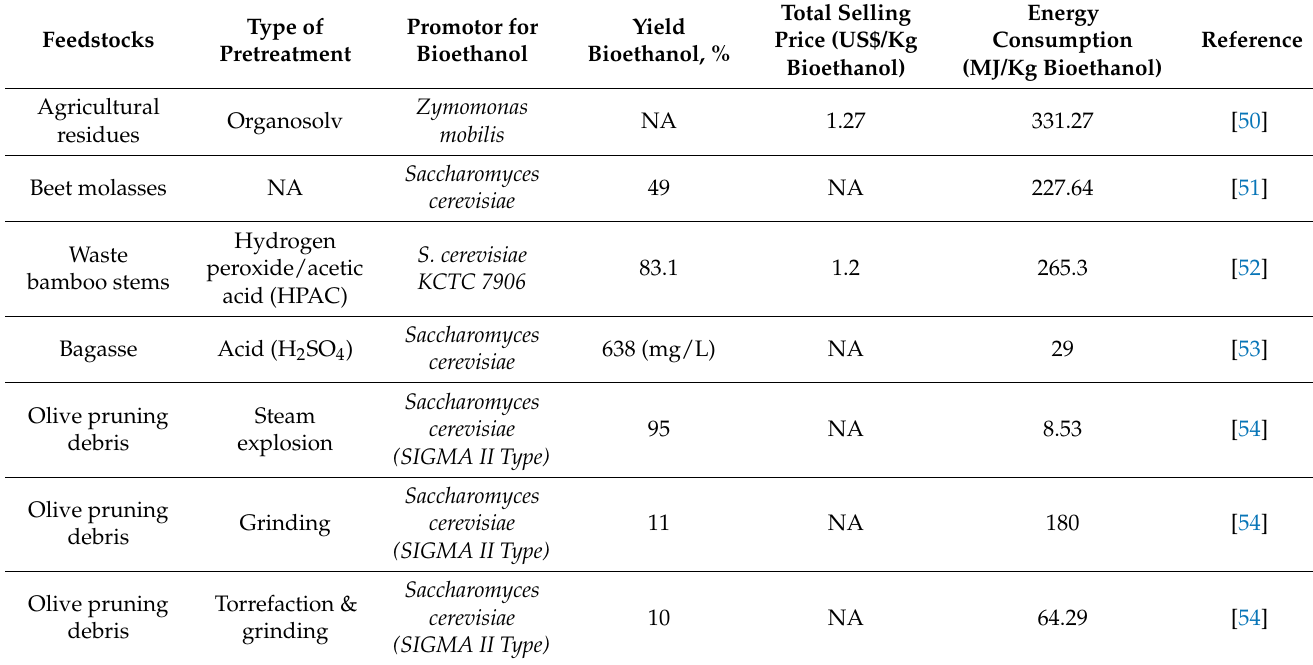
Table 1. Comparison of various pretreatment methods with energy